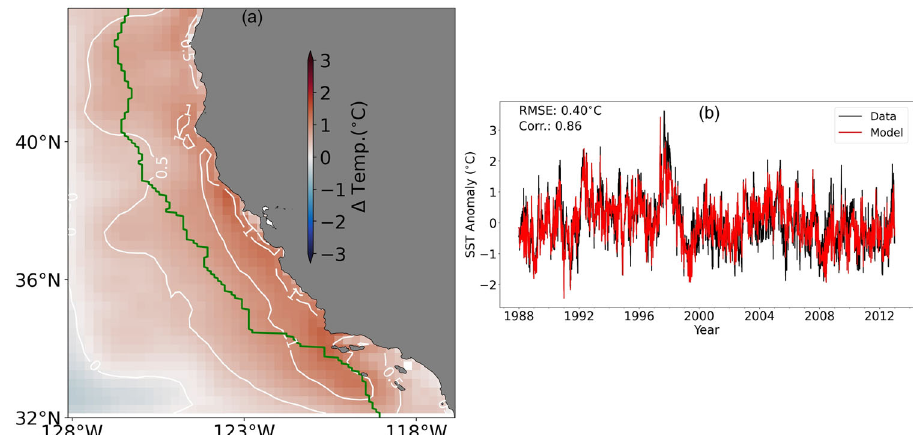
Fig. 3 Model-data validation of sea surface temperature. a Mean model-data bias in sea surface temperature (SST). White lines indicate 0.5 °C contours, while the green line indicates the boundary of the 0 – 200 km offshore zone used to compute b spatially averaged SST, relative to the seasonal mean, between 0 and 200 km offshore and 32 – 44°N, compared to those from the NOAA 1/4° OISST v2.1 product. RMSE = root mean square error and Corr = correlation coef fi